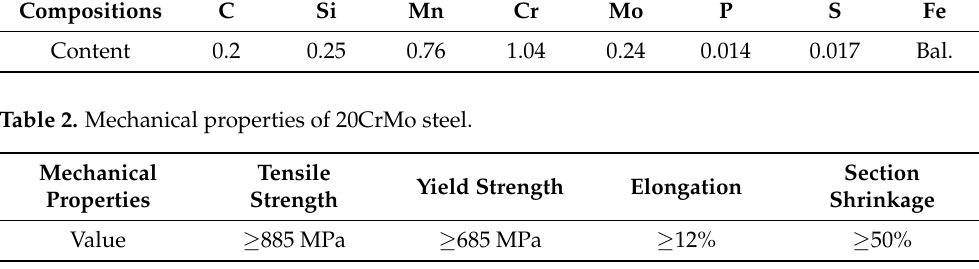
Table 1. Chemical composition of 20CrMo steel (wt.%).